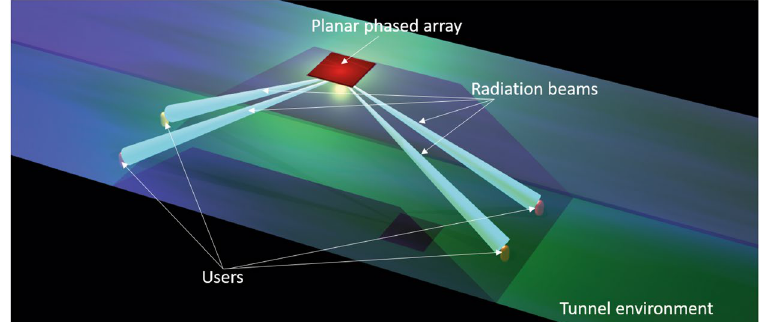
Figure 1. Schematic diagram of a planar phased array used in tunnel environment. Array is installed on the top of tunnel and its radiation beams should direct to near-end-fire directions. Ideally, radiation beams of the tunnel-used array should be automatically directed to